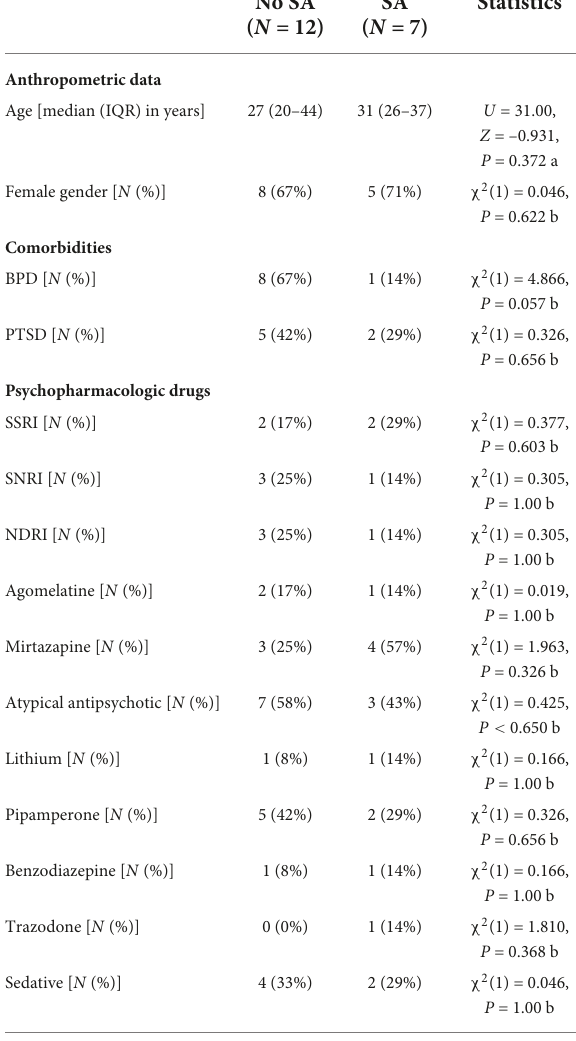
TABLE 2 Anthropometric data and psychopharmacologic drug treatment in MDD/SI subgroups with and without suicide attempt (SA).